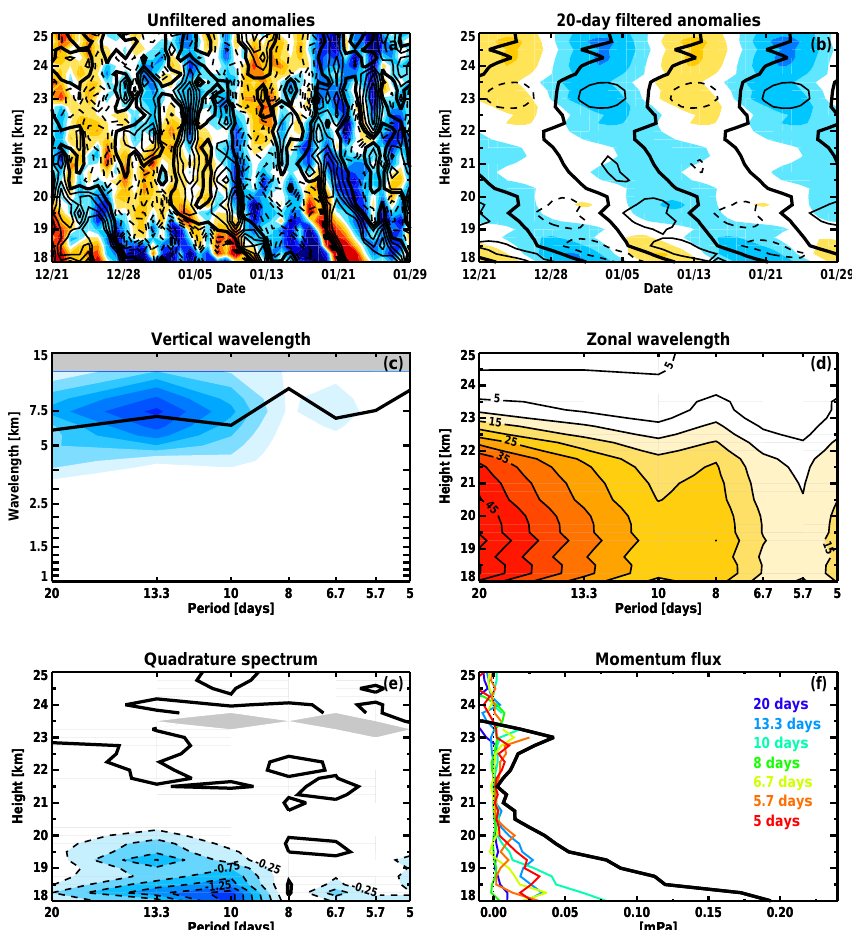
Figure 1. An example of the Kelvin wave momentum flux calculation for Gan Island over the 40-day window between 21 December 2011 and 29 January 2012. (a) Unfiltered zonal temperature anomalies (shading) and zonal wind anomalies (contours). The zonal wind and temperature contour intervals are 2ms − 1 and 1K, respectively. (b) 16–27-day bandpass-filtered temperature and zonal wind over the data window. These correspond to the 20-day period waves in our calculations. (c) 40-day mean vertical quadrature spectrum between u (cid:48) and T (cid:48) (shading) as a function of period and vertical wavelength, and calculated vertical wavelength (black curve, units in km) as a function of period. Dark blue shading indicates large magnitudes of the quadrature spectrum. (d) Zonal wavelength as a function of height and of period. Units are 1000km. (e) The temporal quadrature spectrum between u (cid:48) and T (cid:48) . Units are Kms − 1 . (f) The calculated total 5–20-day momentum flux (black curve) as a function of height. The colored curves show the contributions from individual